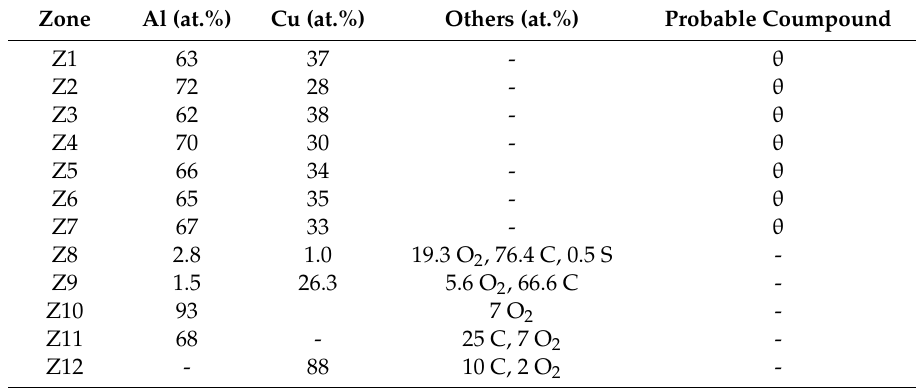
Table 7. The SEM / EDS results obtained from the zones of interest indicated in the images in Figure 5. Zone Al (at.%) Cu (at.%) Others (at.%) Probable Coumpound Z1 63 37 - θ Z2 72 28 - θ -